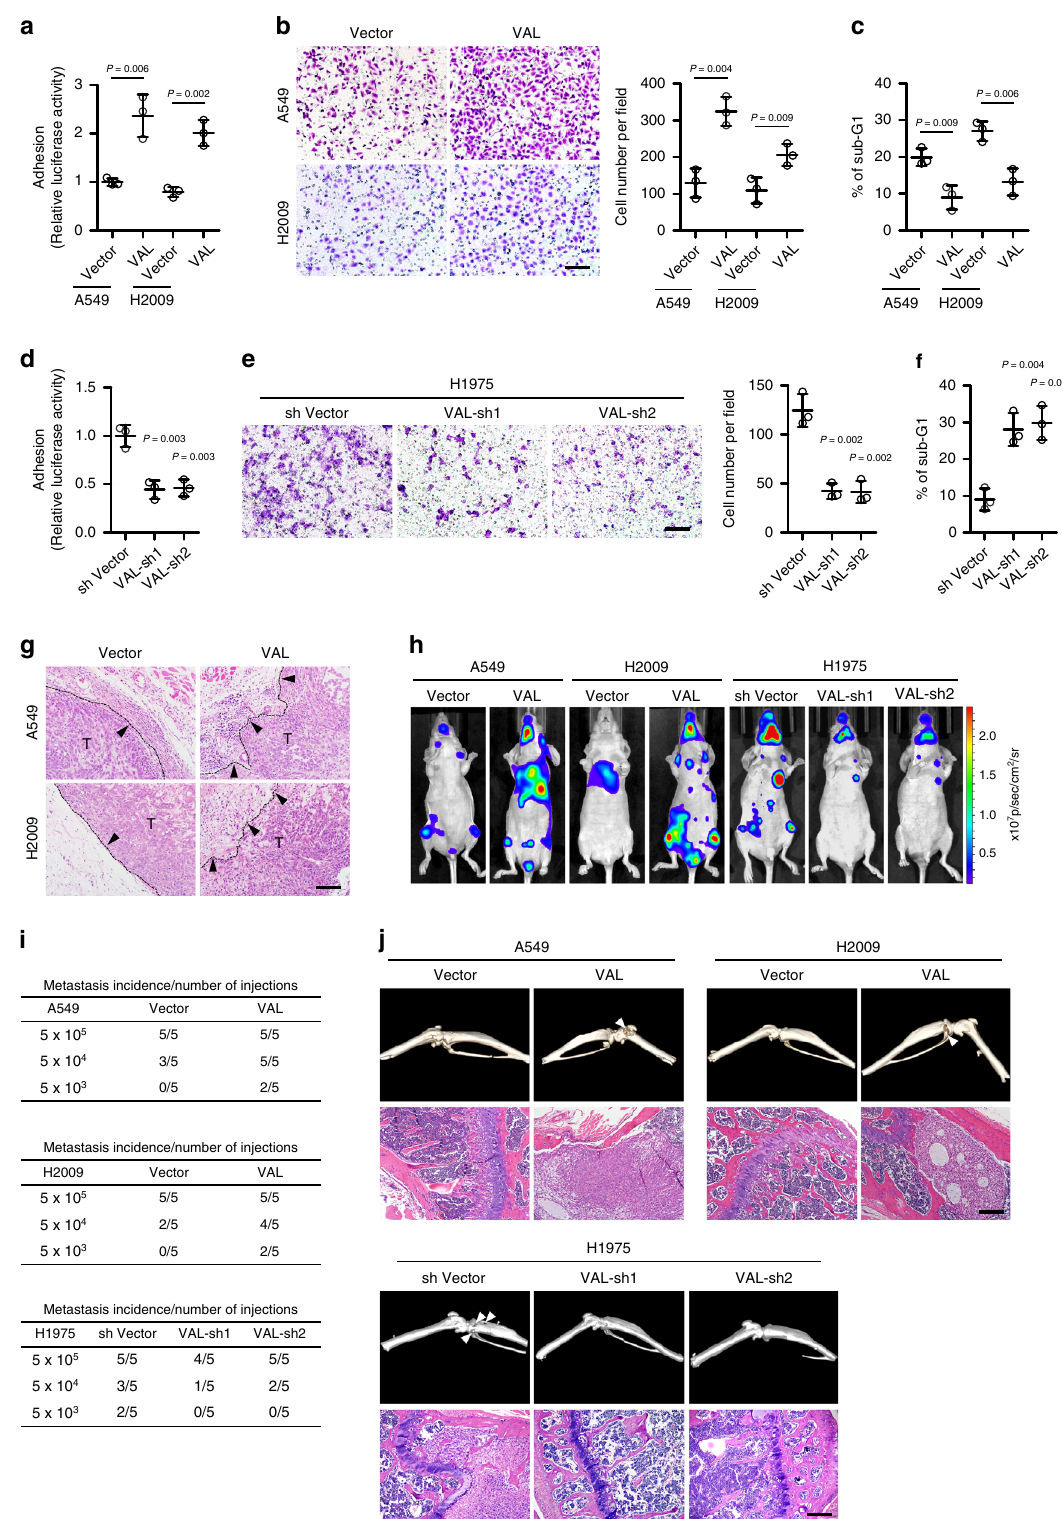
overexpressing LAD cells formed a number of different cancerous lesions in various lobes of the lungs; by contrast, silencing VAL in H1975 cells signi fi cantly suppressed intra-pulmonary metastases (Supplementary Fig. 3k – m). These both in vitro and in vivo data strongly suggest a potent pro-invasive and pro-metastatic role of VAL in LAD